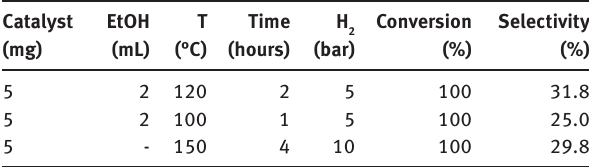
Table 6: Hydrogenation of extracted squalene fraction.